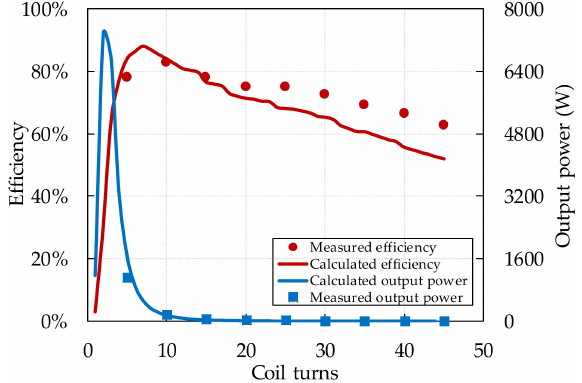
Figure 11. Relationship between coil turns and system performance with fixed outer